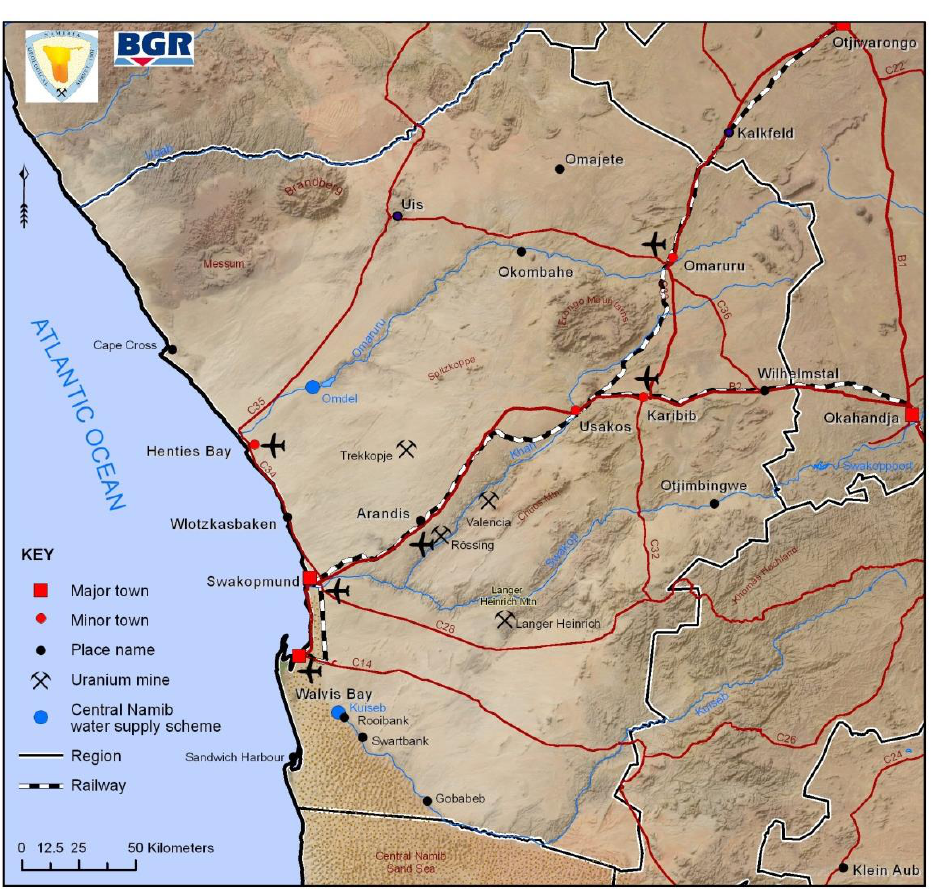
Figure 1. The locality map of the study area/ Langerheinrich mine (Source: BGR).